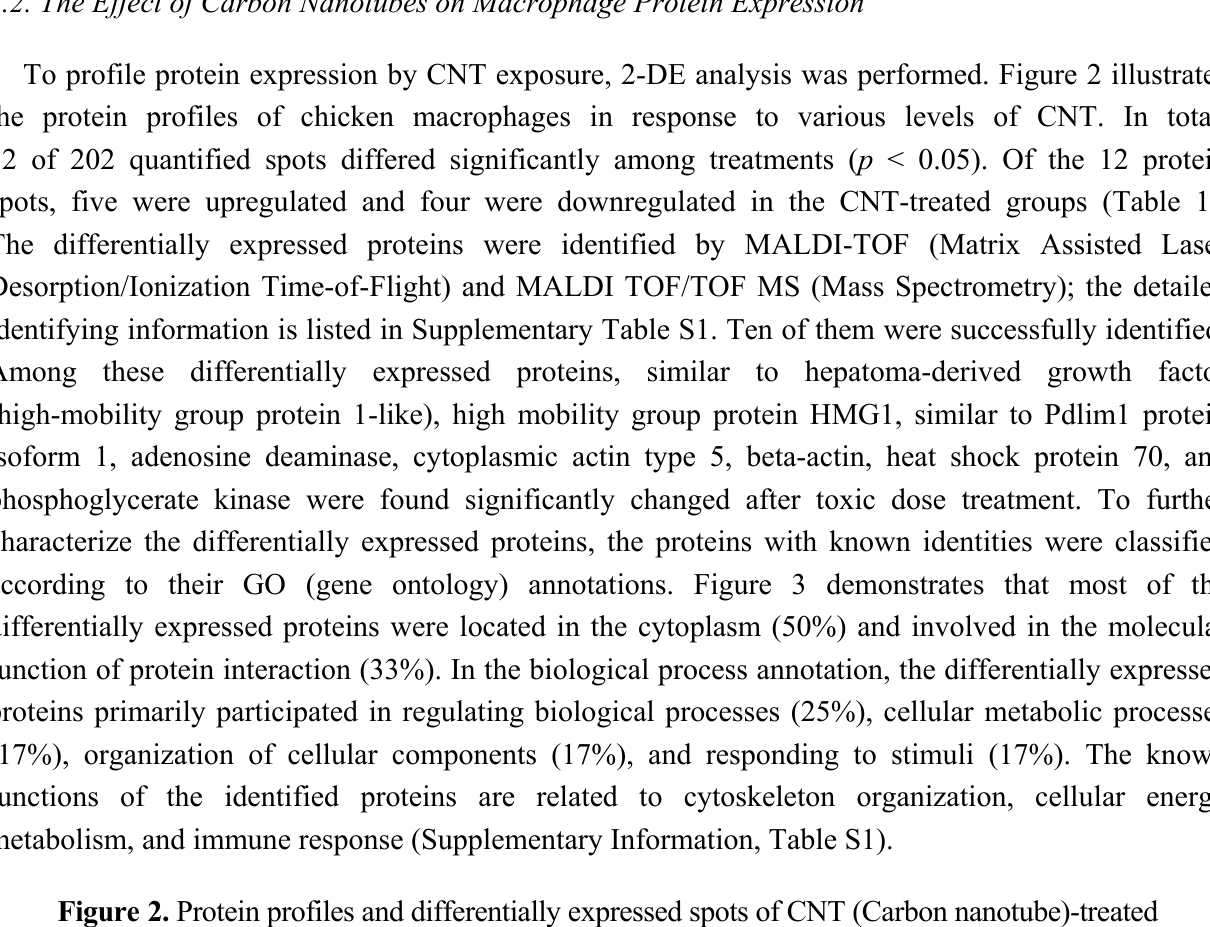
Figure 2. Protein profiles and differentially expressed spots of CNT (Carbon nanotube)-treated chicken macrophages. Macrophages were treated with 0 μ g/mL ( A ); 1 μ g/mL ( B ); 10 μ g/mL ( C ); and 100 μ g/mL ( D ) carbon nanotubes, then proteins were extracted